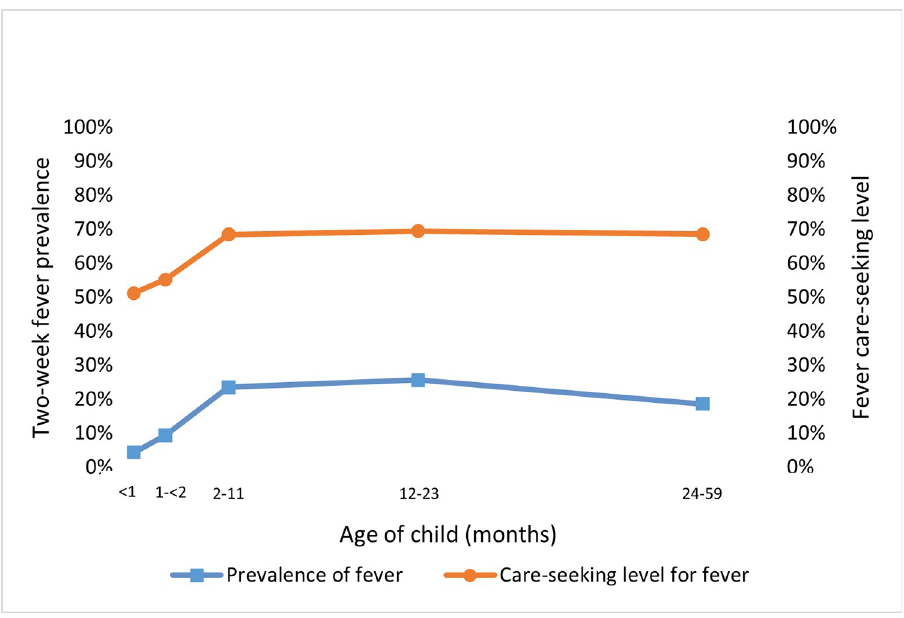
Fig 4. Illness prevalence and care seeking level by age